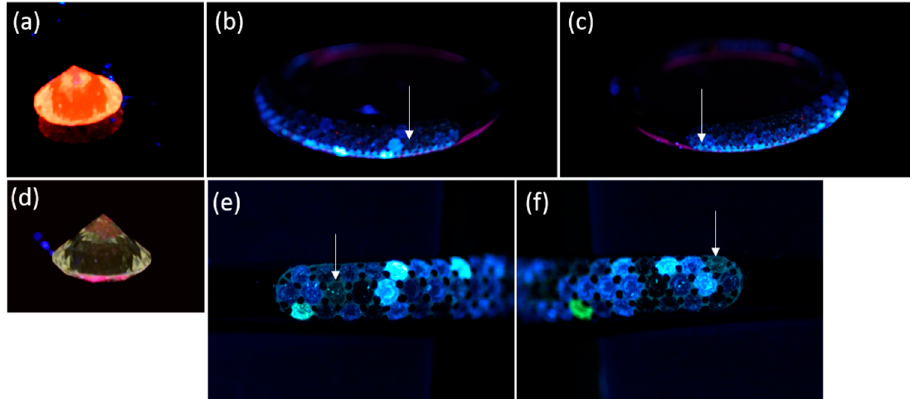
Figure 6. Photograph of ( a ) orange fluorescing natural diamond with NV − , ( b,c ) ring as in Figure 5, CZ stones indicated by arrows excited by LWUV (366 nm) gemmological lamp showing no observable luminescence, ( d ) loose ~5 mm CZ stone showing weak yellow fluorescence also excited by LWUV, ( e,f ) images of same ring, CZ stones indicated by arrows, excited by SWUV (<240 nm), showing weak blue-grey luminescence.